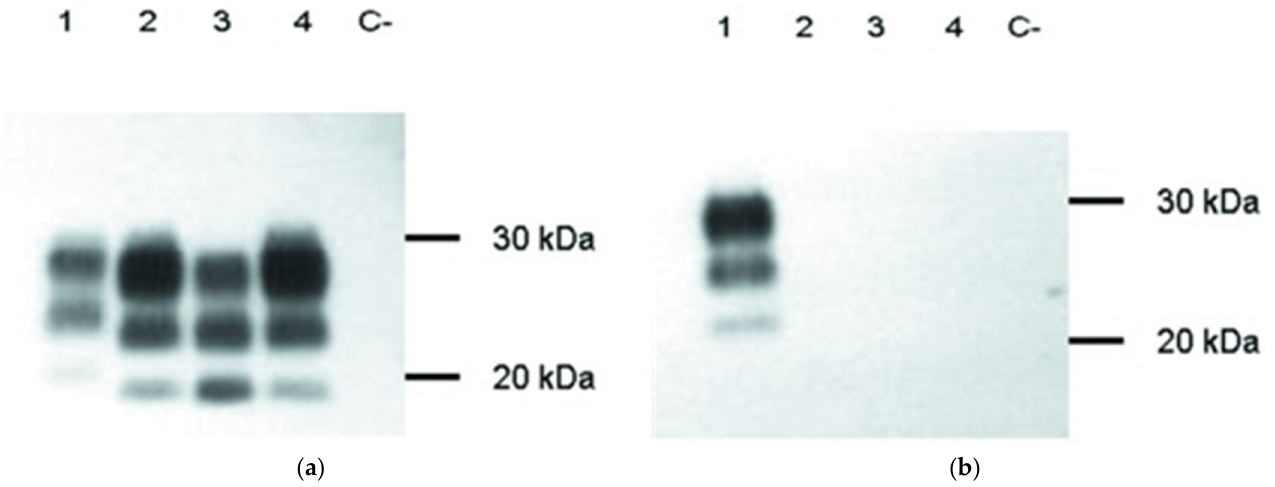
Figure 4. Western blot analysis. H-type BSE (1), C-type BSE (2), L-type BSE (3), and C-type BSE (4) samples and healthy bovine used as negative control (C-). mAbs 6H4 ( a ) and P4 ( b ) were used, respectively. Adapted from Ref. [35].